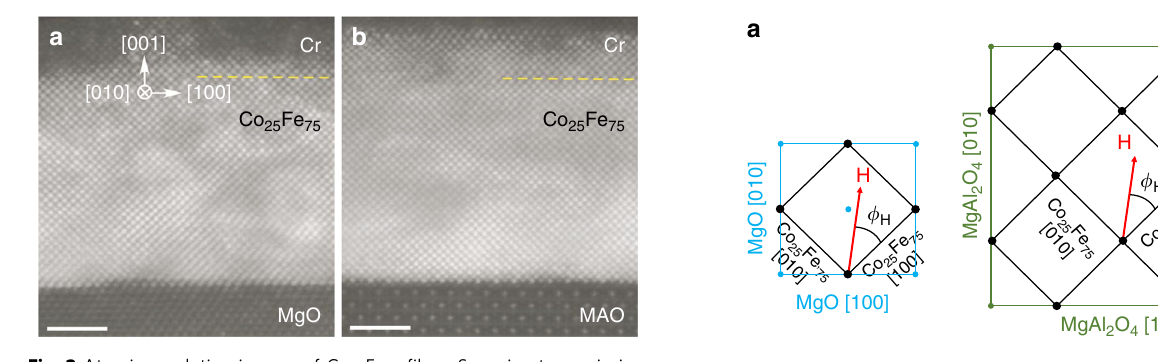
scans of a Cr(2.8 nm)/Co 25 Fe 75 (6.8 nm) bilayer on MgO and MAO, respectively, where the fi tting gives a fi lm roughness of 0.4 nm for both samples.